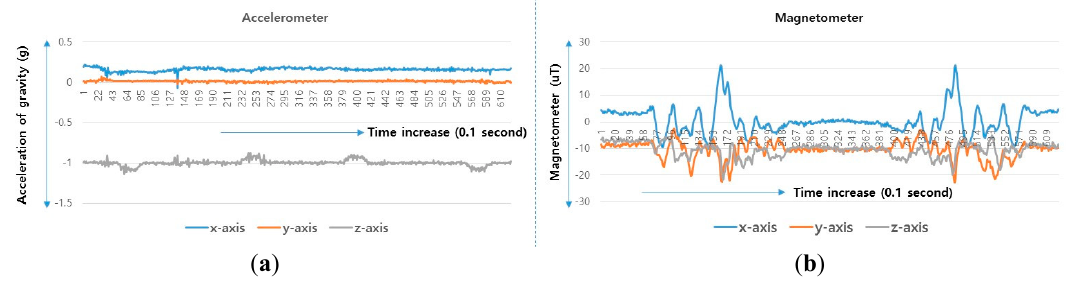
Figure 2. Accelerator/magnetometer fluctuation pattern corresponding to elevator: ( a ) Accelerometer, ( b ) magnetometer.